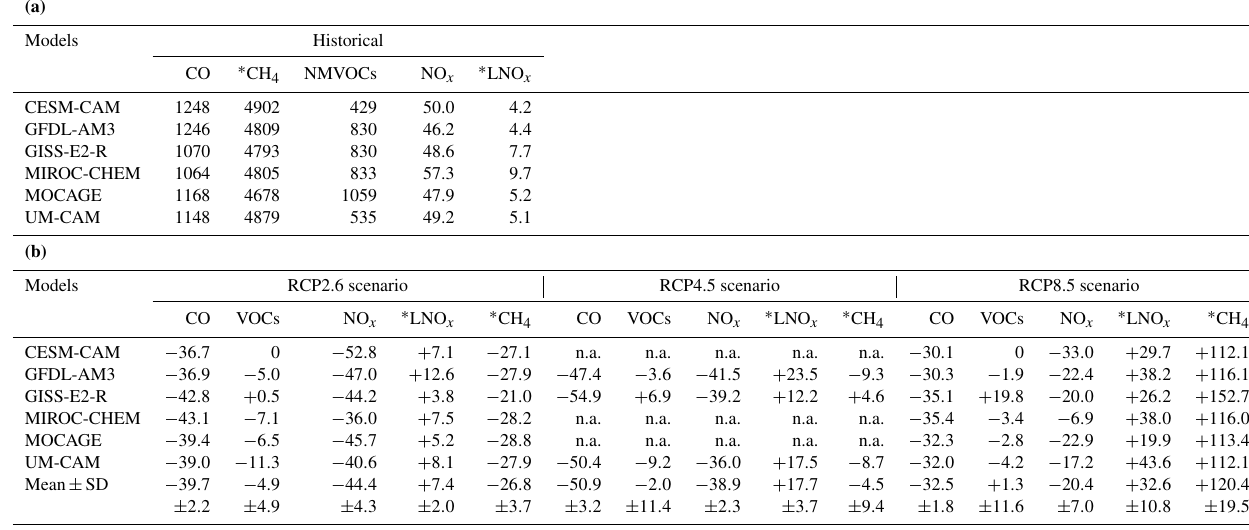
Table 2. (a) Annual total emissions of CO (TgCOyear − 1 ), NMVOCs (TgCyear − 1 ), NO x (TgNyear − 1 , including lightning and soil NO x ), total lightning NO x emissions (LNO x ) and global atmospheric methane (CH 4 ) burden (Tg) for the historical simulations in each model (from Young et al., 2013, and ∗ from Voulgarakis et al., 2013). (b) Simulated percentage (%) changes in total emissions of CO, NMVOCs, NO x (including lightning and soil NO x ), total lightning NO x emissions (LNO x ) and global atmospheric CH 4 burden for each model between 2100 and historical simulation for RCPs (from Young et al., 2013, and ∗ Voulgarakis et al., 2013). The last row shows means and SDs. Missing or not available data are identified